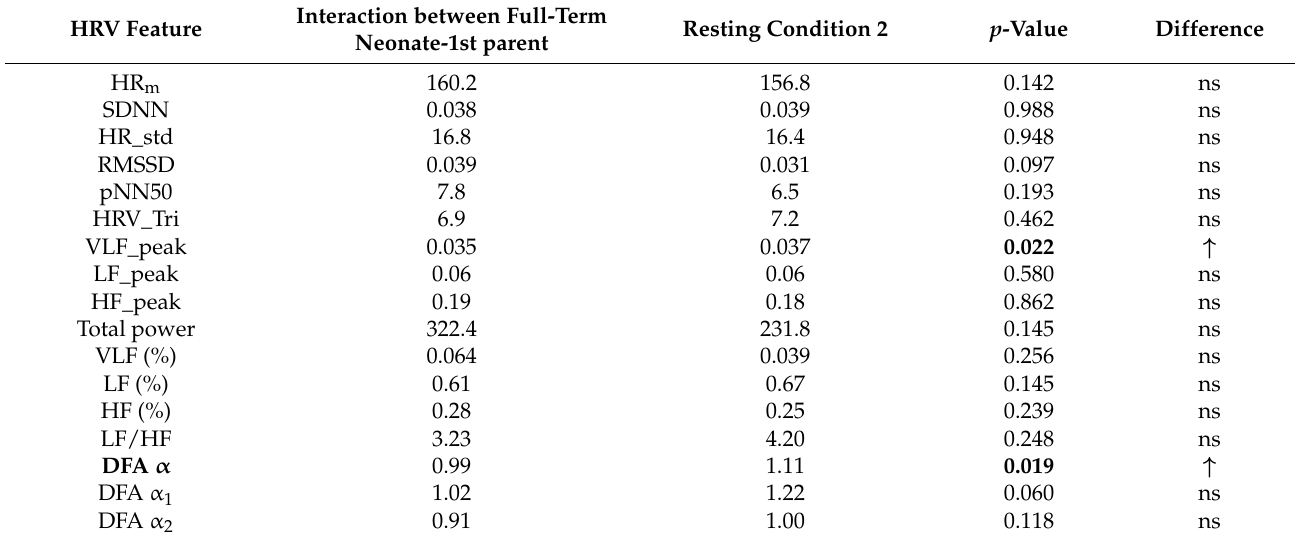
Table 8. Comparison of full-term infants’ HRV parameters between interaction with the 1st parent and resting condition 2.